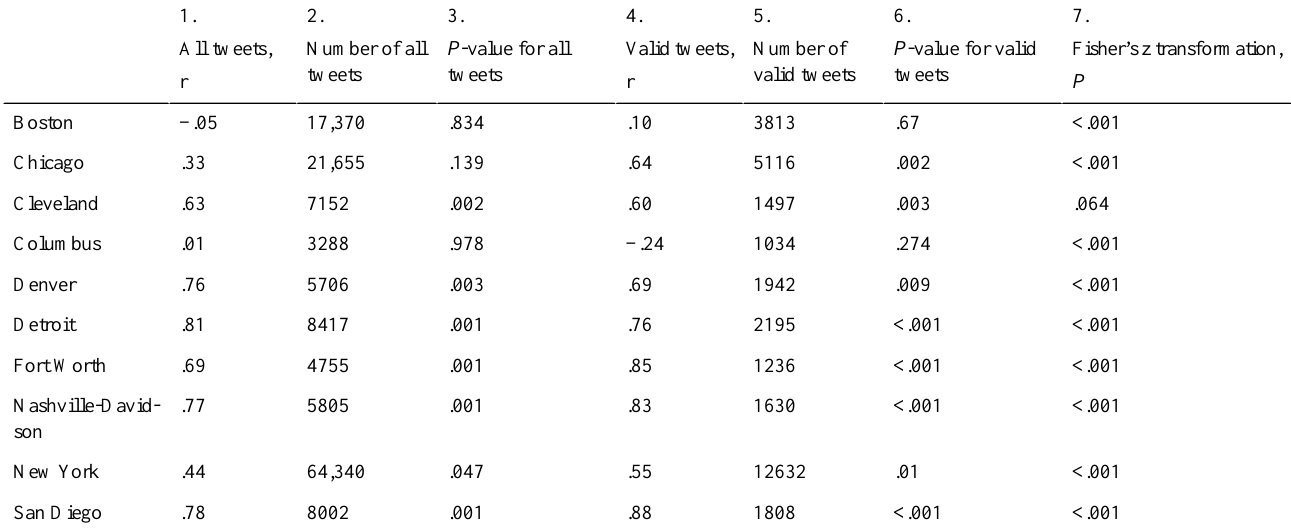
Table 3. Correlations between valid tweets and sentinel-provided ILI a rates. b